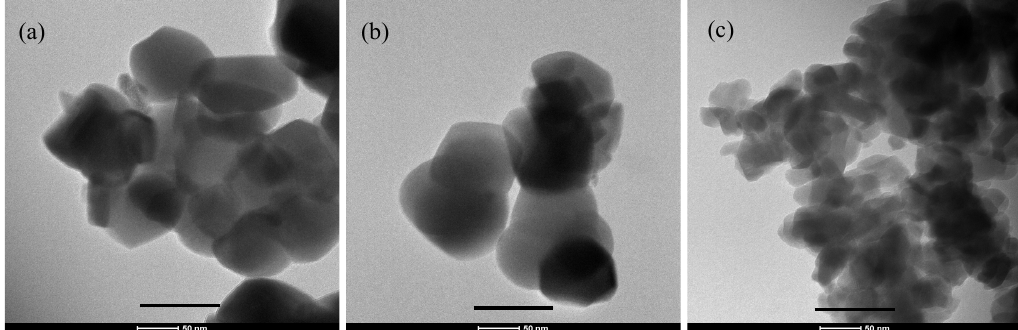
Figure 1. TEM micrograph of synthesized ( a ) HA, ( b ) HA-Mg and ( c ) HA-Si (scale bar = 100 nm).